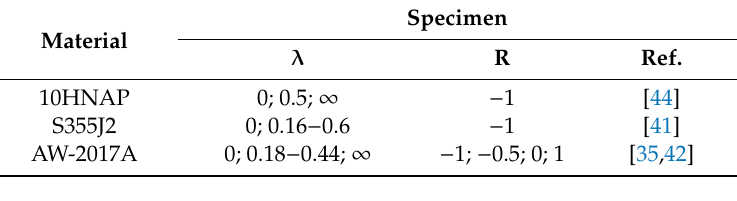
Table 3. The loading parameters.